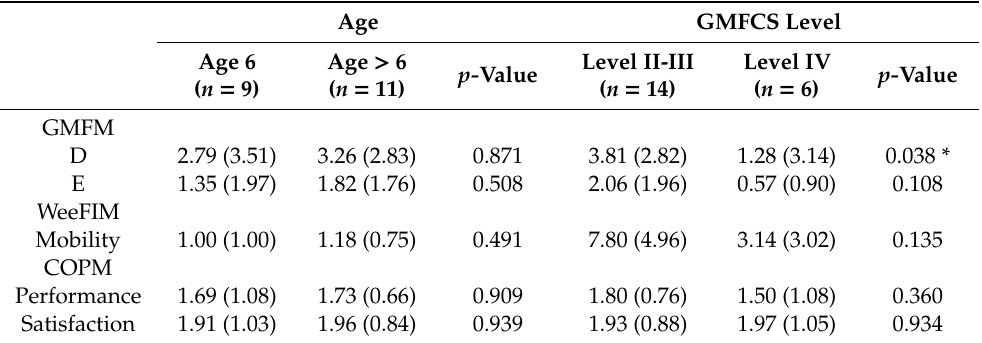
Table 5. The changes of functional outcome measures according to age and GMFCS